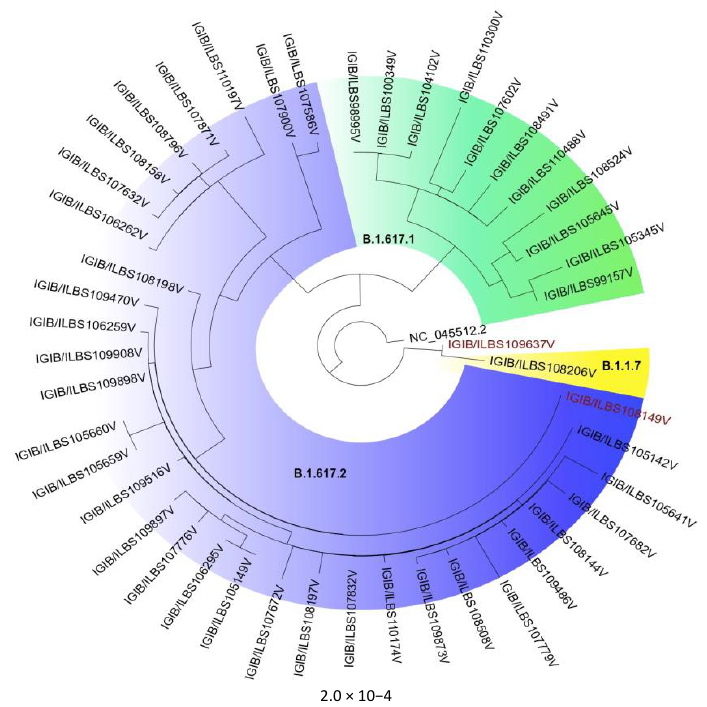
Figure 2. The phylogenetic distribution of lineages in 46 vaccinated samples.